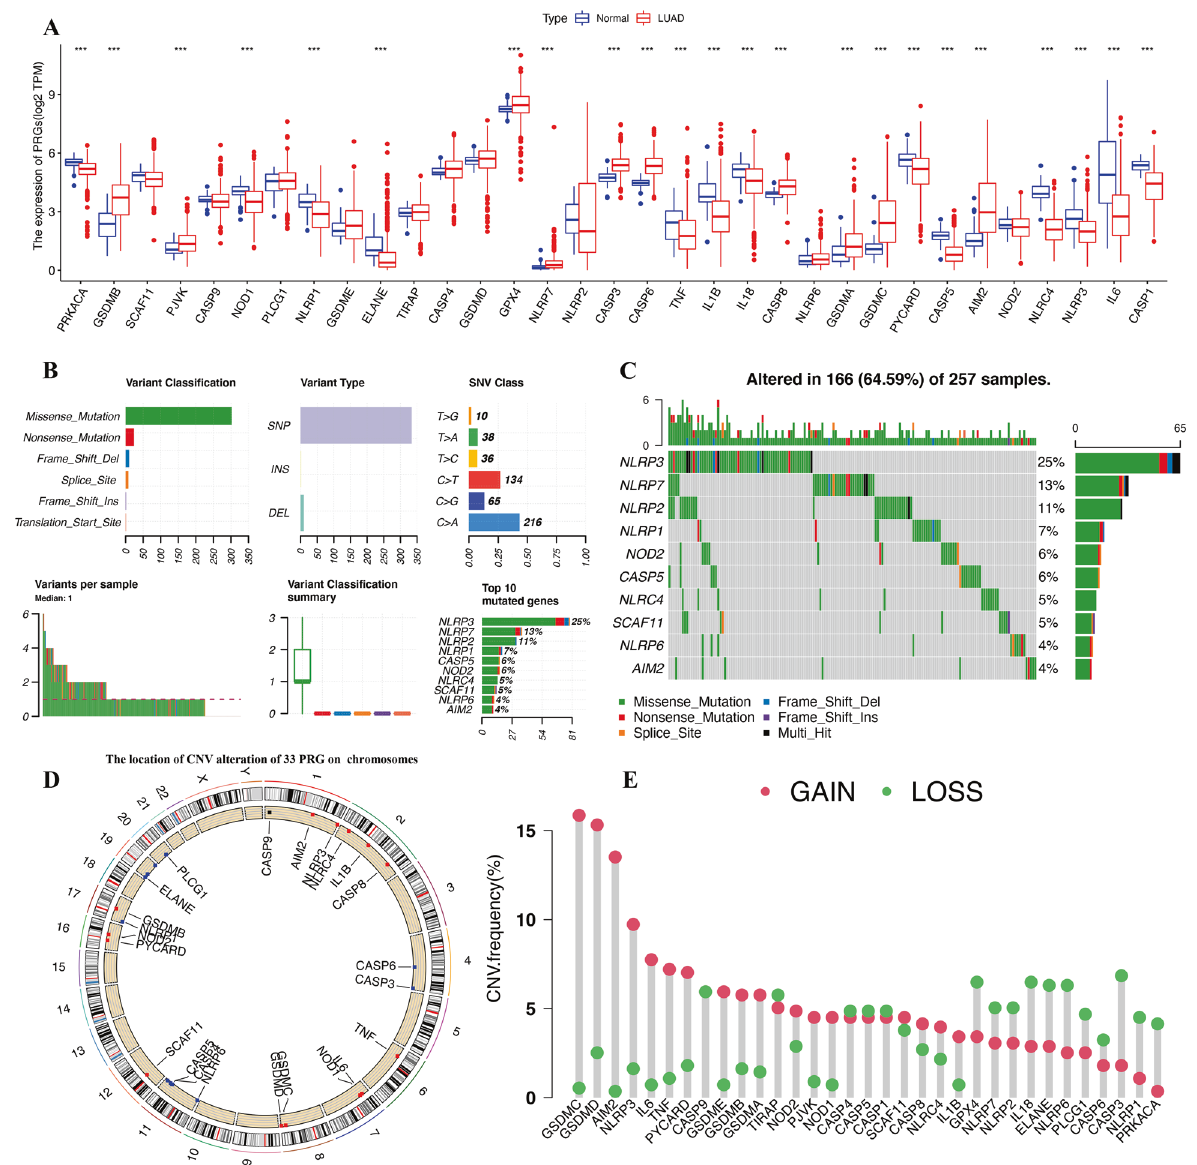
Fig. 1 Landscape of genetic and expression variation of PRG in LUAD. A The expression of 33 PRG in LUAD and lung tissues, Tumour, red; Normal, blue. The upper and lower ends of the boxes represented the interquartile range of values. The lines in the boxes represented median value. B, C The mutation frequency and classi fi cation of 33 PRG in LUAD. D The location of CNV alteration of 33 PRG on 23 chromosomes in the LUAD cohort. E The CNV variation frequency of 33 PRG in the LUAD cohort. The height of the column represented the alteration frequency. *** P < 0.001, PRG pyroptosis ‑ related gene, LUAD lung adenocarcinoma, SNP single nucleotide polymorphism, INS insertion, DEL